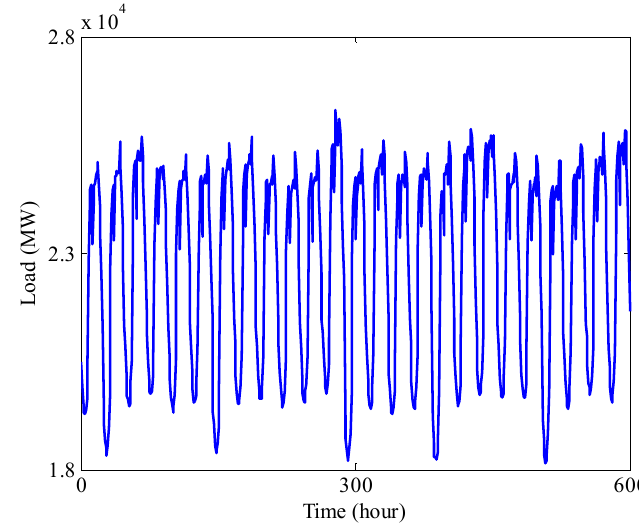
Figure 3. The training hourly actual load data in Case 1.